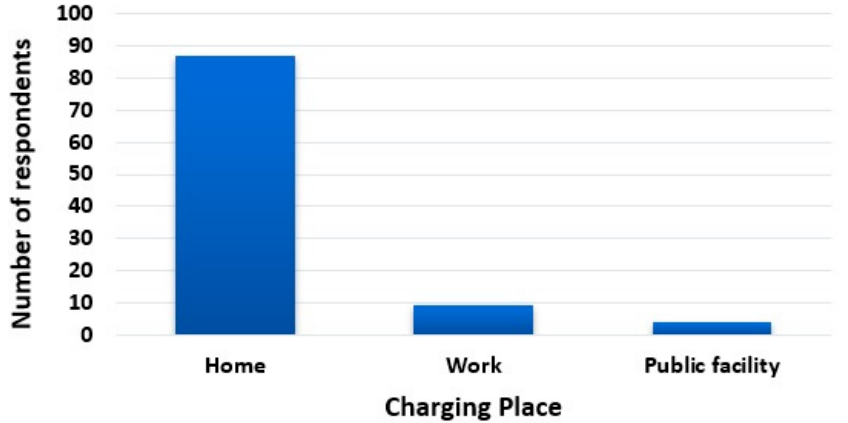
Figure 4. Respondent responses for preferred charging place.